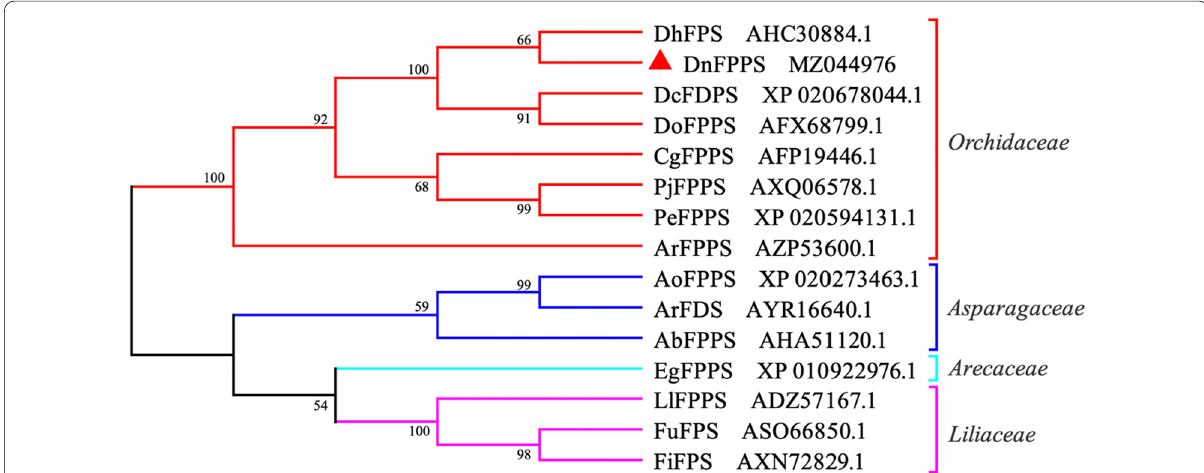
Fig. 4 Phylogenetic analysis of amino acid sequences between DnFPPS and other plants FPPS. Maximum Likelihood phylogenetic tree was constructed using MEGA7.0 software. The numbers at nodes represent 1000 bootstrap replicates. The accession numbers were as follows: DhFPS, Dendrobium huoshanense ; DcFDPS, Dendrobium catenatum ; DoFPPS, Dendrobium officinale ; CgFPPS, Cymbidium goeringii ; PjFPPS, Phalaenopsis japonica ; PeFPPS, Phalaenopsis equestris ; ArFPPS, Anoectochilus roxburghii ; AoFPPS, Asparagus officinalis ; ArFDS, Asparagus racemosus ; AbFPPS, Albuca bracteate ; FuFPS, Fritillaria unibracteata ; LlFPPS, Lilium longifloraria ; EgFPPS, Elaeis guineensis ; FiFPS, Fritillaria imperialis